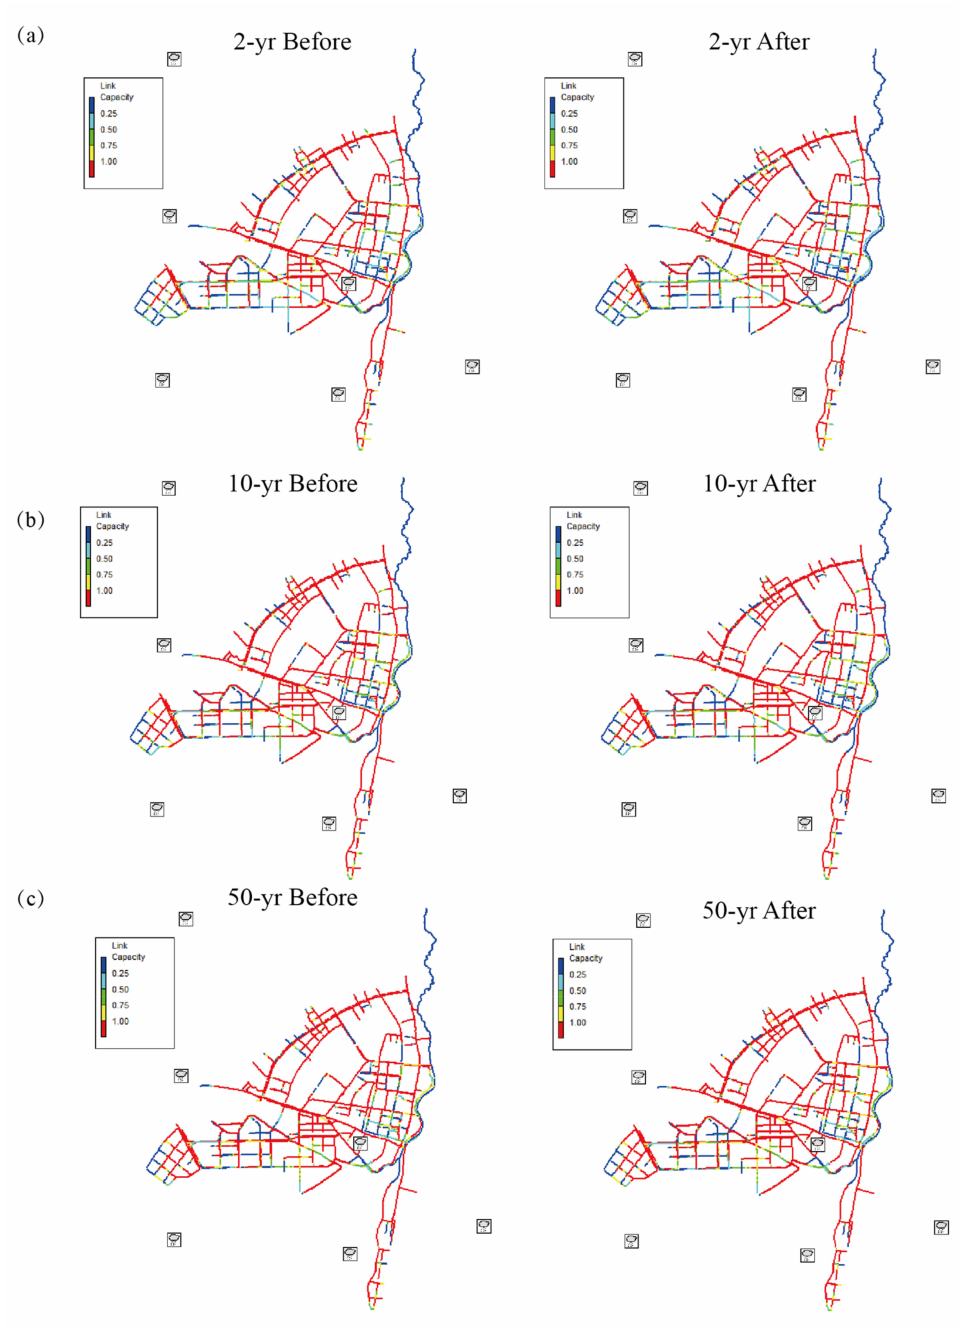
Figure 10. The distribution of drainage capacity under different rainfall return periods. ( a ) 2 years; ( b ) 10 years; ( c ) 50 years. Table 7. Statistics analysis on waterlogging reduction effect under different return periods (km 2